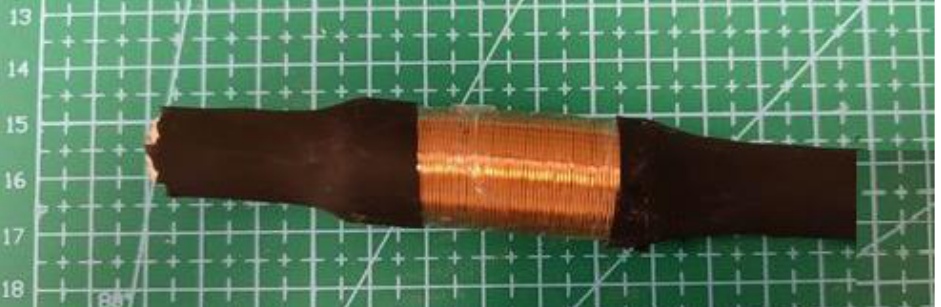
Figure 5. A finished microgenerator. After comparing two sets of microgenerators, one with Ø10 mm and one with Ø8 mm magnets, two generators were deemed to be the most efficient. Both of these generators were 50 mm in length, had 600 turns, and contained a set of 20 magnets. Then, 3 such generators were combined, creating a larger microgenerator system of two Ø10 mm and one Ø8 mm magnets. The three generator system is shown in Figure 6.